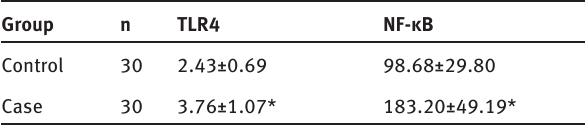
Table 1: NF-κBp65 and TLR4 level in serum of the two groups (ng/ml)